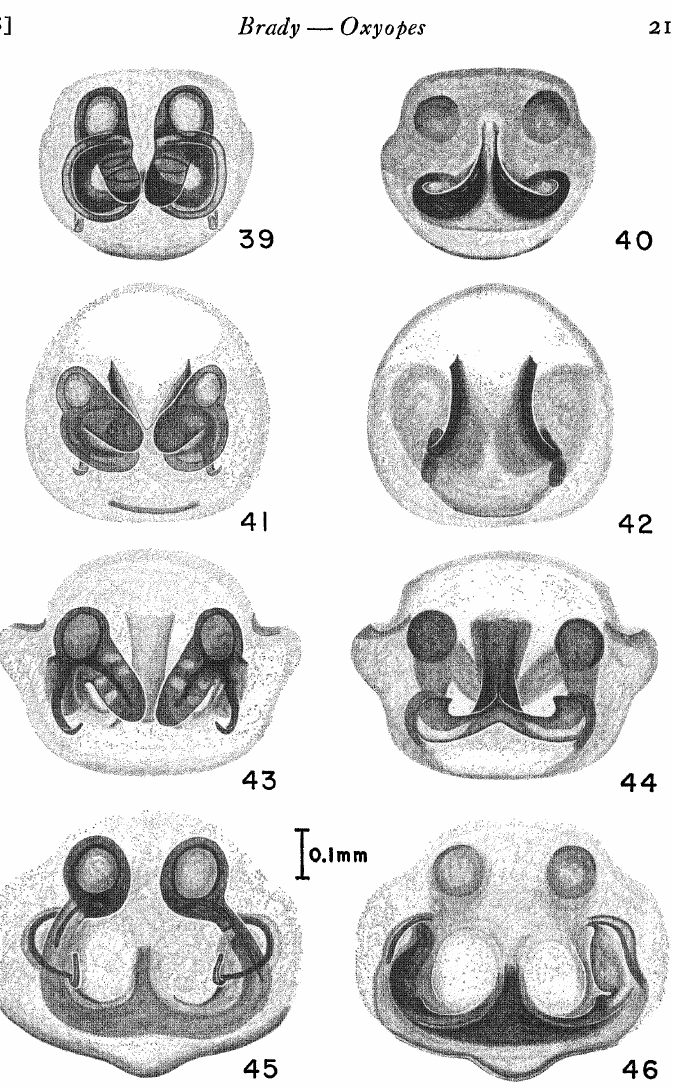
Figs. 39-40. Oxyopes felinus Brady, female from SW of Acaponeta, Nayarit, 15 May 1965. 39. Internal genitalia. 40. Epigynum. Figs. 1-42. Oxyopes ocelot new species, female for Arcelia, Guerrero, 2 Nov. 197. 1. Internal genitalia. 2. Epigynum. Figs. 43-4. Oxyopes cornutus F.O.P.-Cambridge, female from 8 mi. SW of Colima, Colima, 10 May 1963. 43. Internal genitalia. 44. Epigynum. Figs. 45-46. Oxyopes panther new species, female from Palos Colorados, 25 mi. W of Durango, Aug. 197. 5. Internal genitalia. 6.